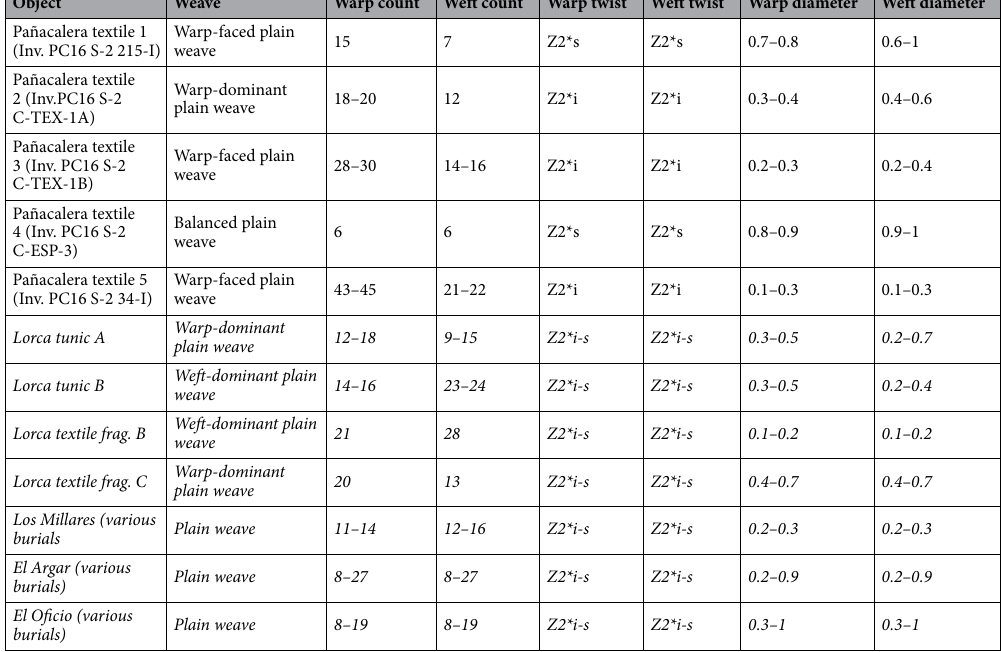
Table 1. Textile structural data summary for the five textiles from Peñacalera and (in italics) other Copper and Bonze Age Iberian textile finds (data for Lorca from 8,9 ; for Los Millares, El Argar and El Oficio from 4,5